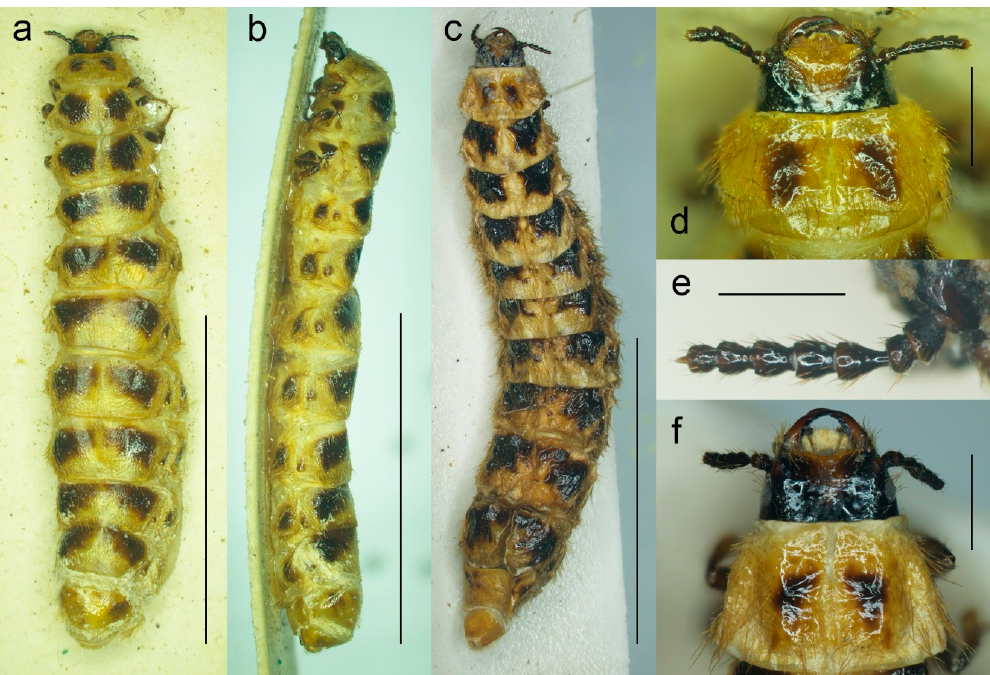
Figure 6. Malacogaster sp., female morphology. ( a ) Specimen from northern Africa (MNHN), habitus, dorsal view; ( b ) specimen from northern Africa (MNHN), habitus, lateral view; ( c ) specimen from Mallorca (MZLU), habitus dorsal view; ( d ) specimen from northern Africa (MNHN), head, dorsal view; ( e ) specimen from Mallorca (MZLU), right antenna; ( f ) specimen from Mallorca (MZLU), head, dorsal view. Scale bars = ( a – c ) 10.0 mm; ( d , f ) 1.0 mm; ( e ) 0.5 mm.